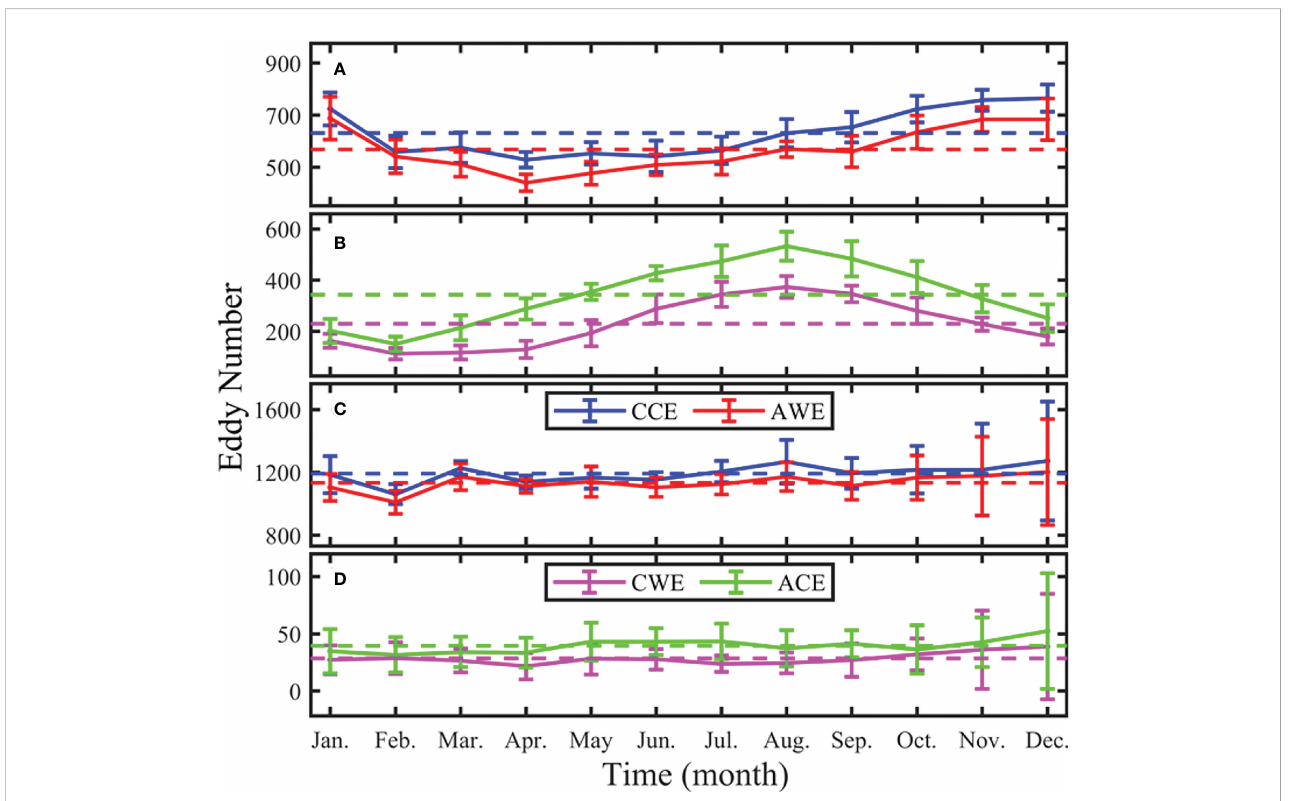
FIGURE 1 Monthly distribution of multi-year (2008 ~ 2017) average eddy number at the sea surface (A, B) and 1,000 m (C, D) in the STCC region. Blue, red, pink, and green curves represent cyclonic cold-core eddy, anticyclonic warm-core eddy, cyclonic warm-core eddy, and anticyclonic cold-core eddy, respectively. The bar represents the standard deviation, and the dotted line represents the multi-year average